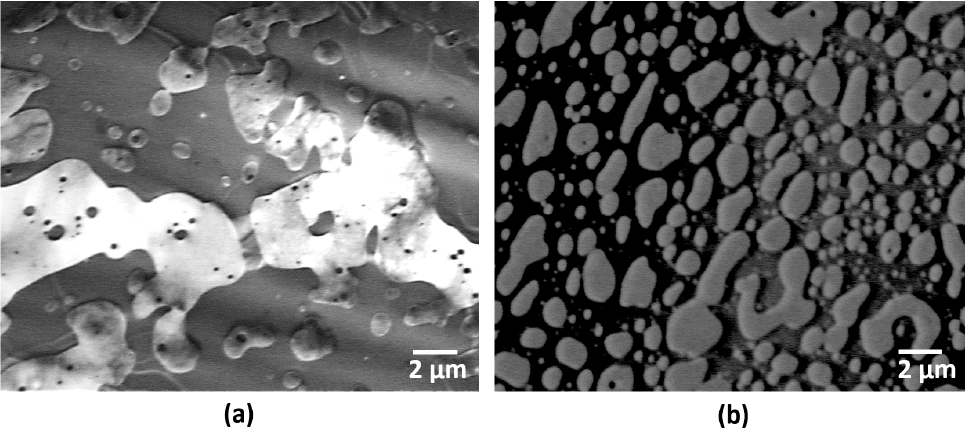
Figure 3. STEM micrographs of ( a ) PLA:SEBS and ( b ) PLA:TPU where both blends are of a 50:50 by weight